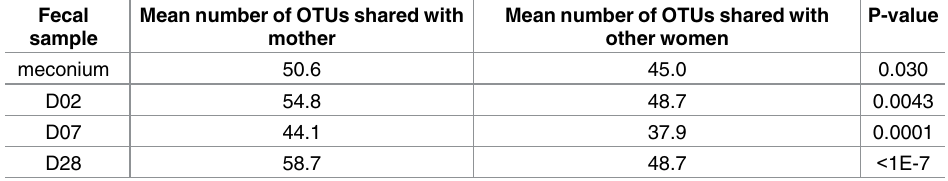
Table 3. Results of the permutation tests. Average numbers of shared OTUs betweenthe newbornsam- ples and the sample of the mother or of the other women includedin the mothers’ group.